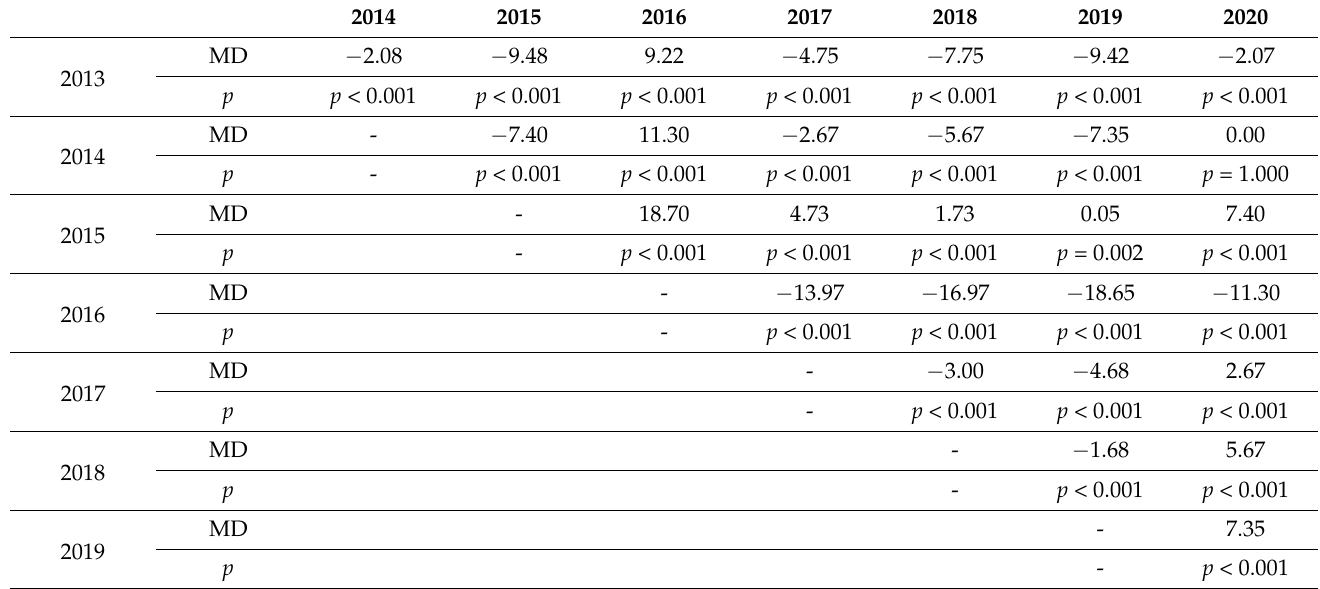
Table 2. Comparison of confirmation of SCA by members of MRT in individual editions of the Championships.